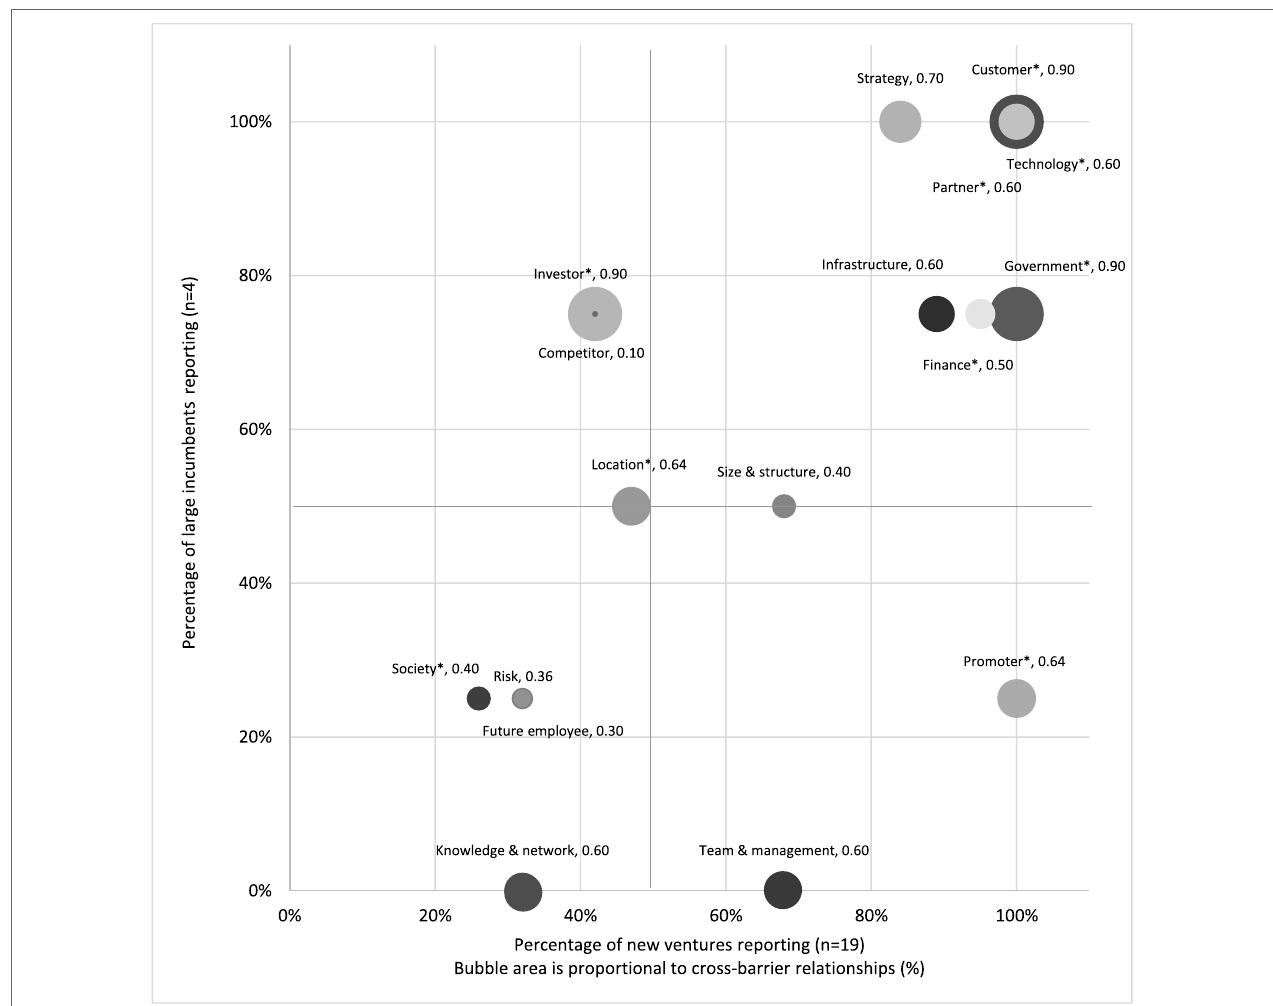
FigUre 4 | Reported barrier category matrix: new ventures vs. incumbents. *Perceived main barrier reported in